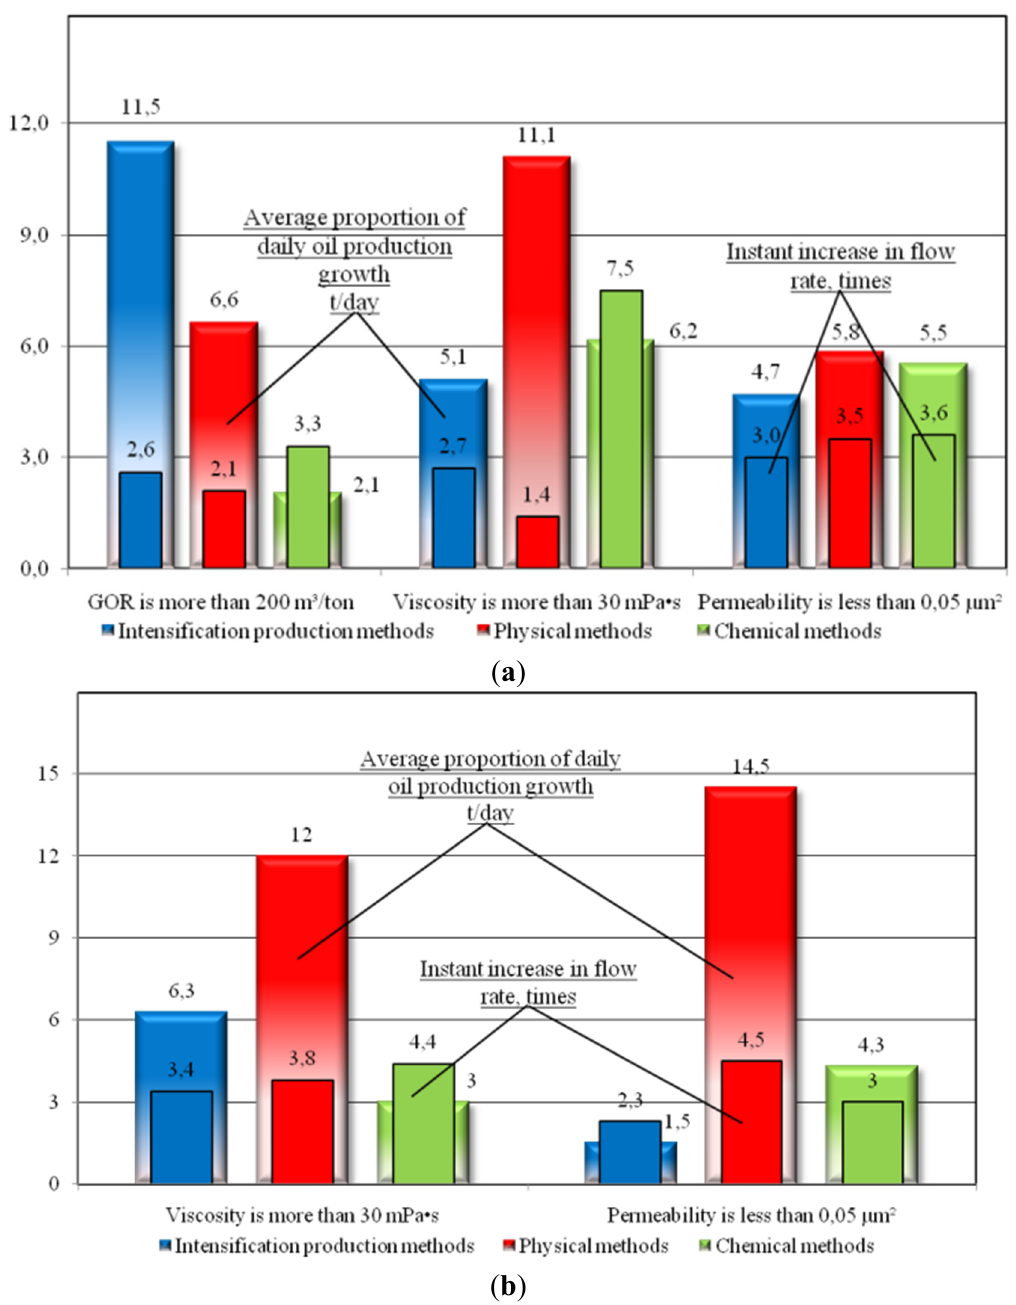
Figure 1. Enhanced oil recovery methods efficiency on the field of the East part of the Volga-Ural oil and gas province ( a ) in carbonate reservoirs; ( b ) in clastic